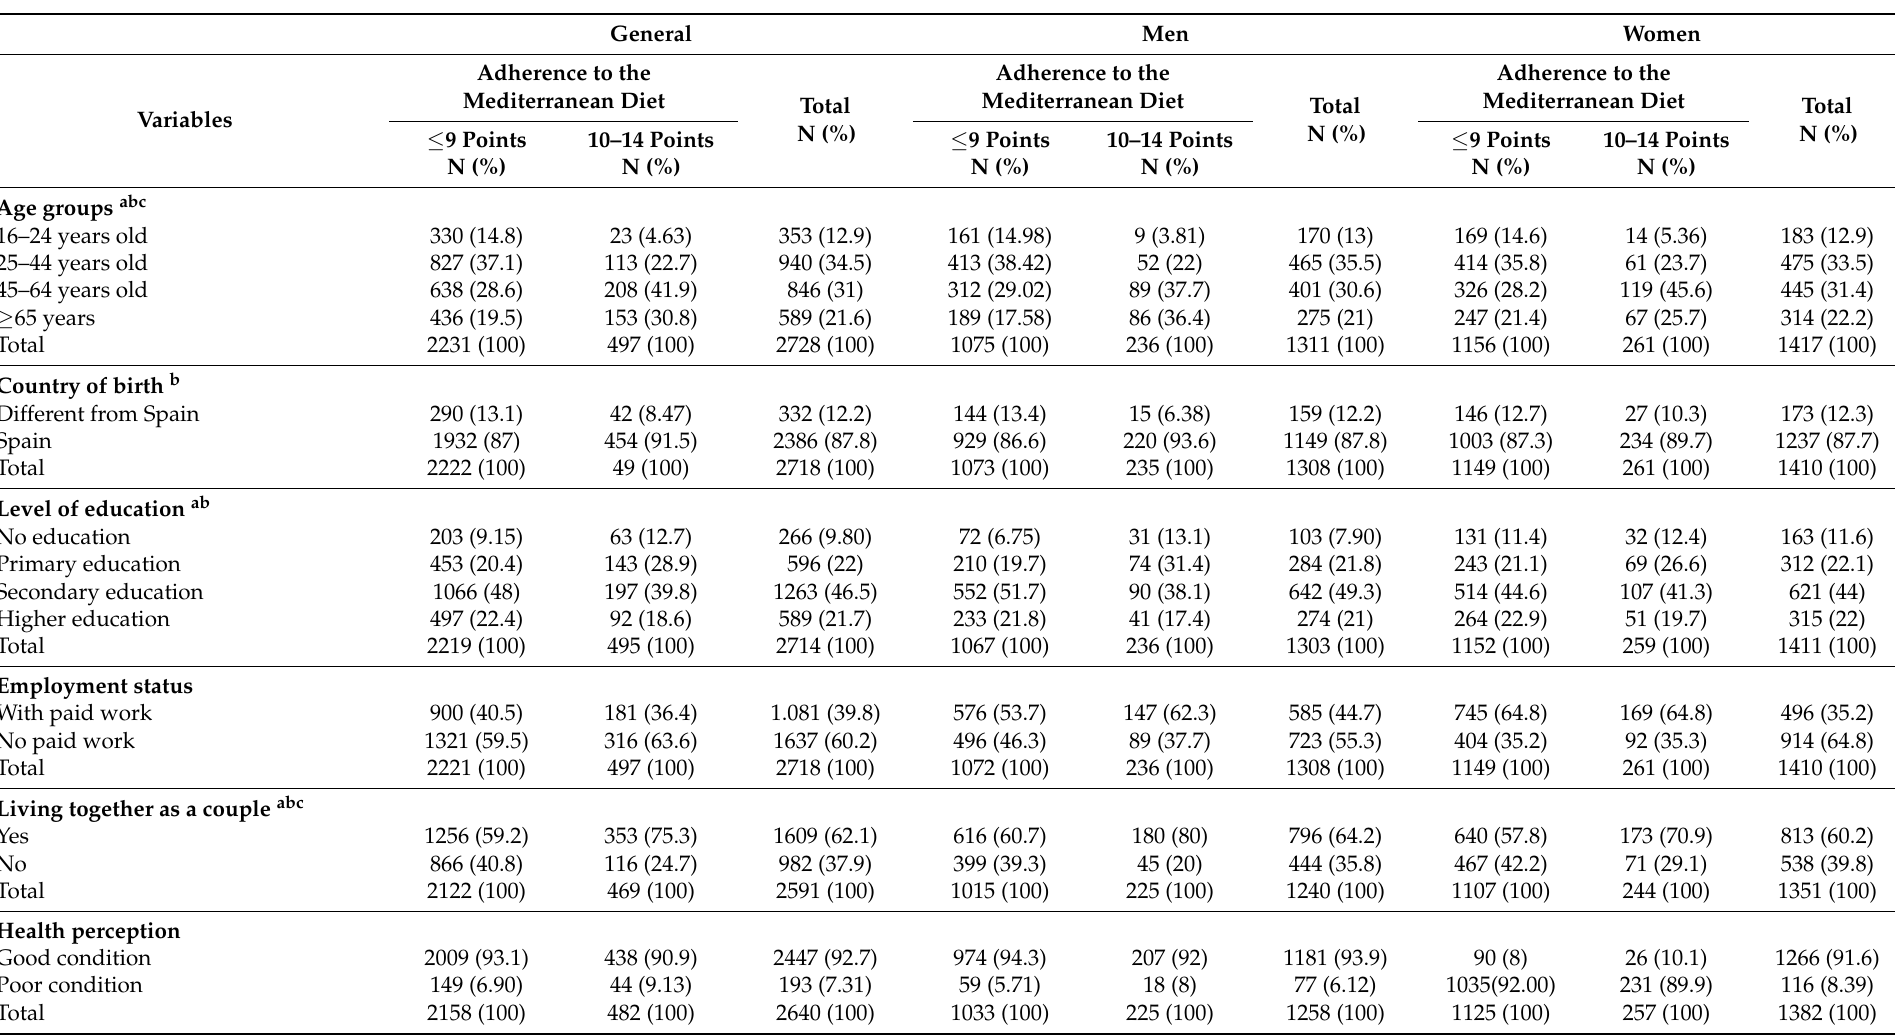
Table 1. Distribution of the sample according to the determinants of health based on the level of adherence to the Mediterranean